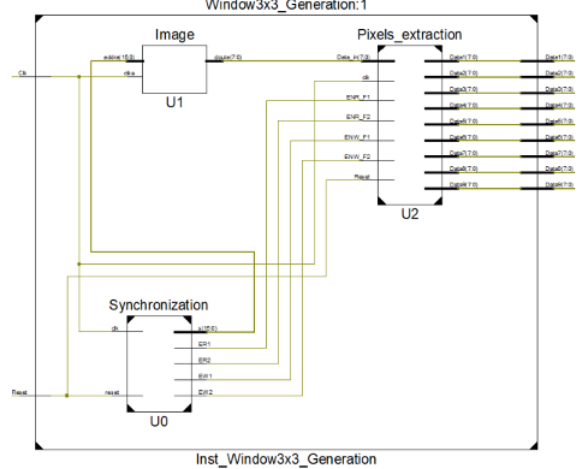
Fig. 10. RTL Schematic for the window generator